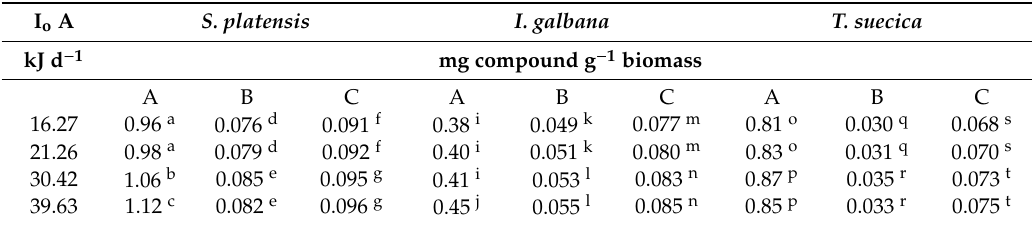
Table 6. Phenol, alkaloids, and terpenoids content of three microalgae in continuous cultures at di ff erent light